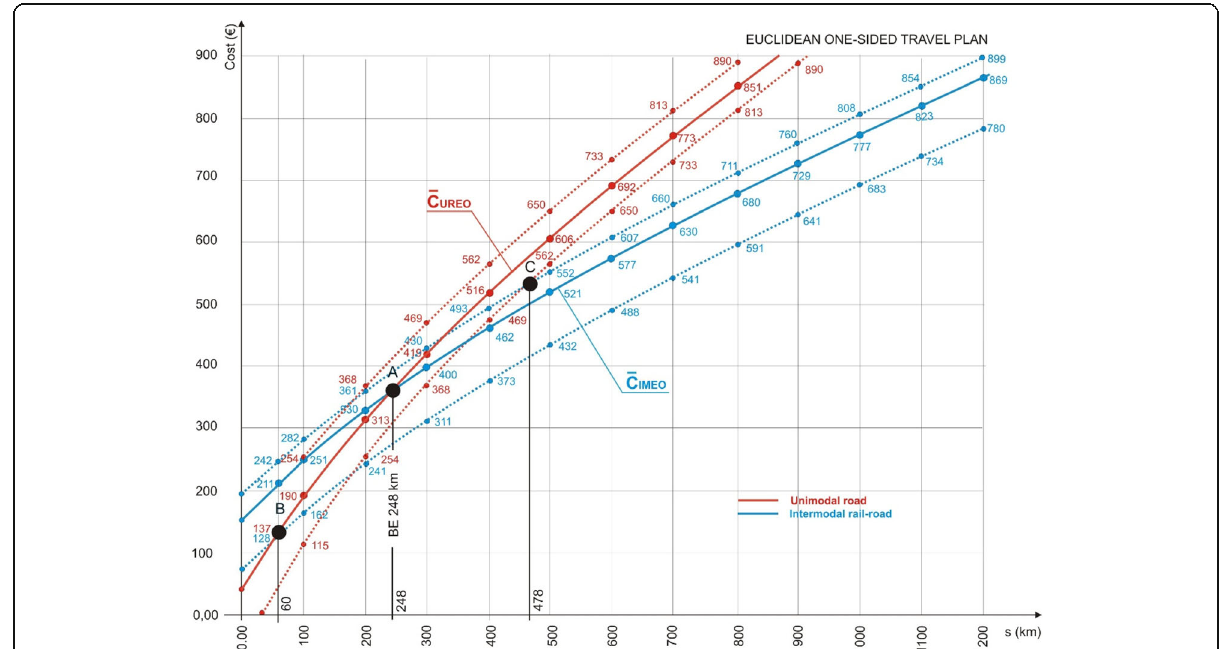
Fig. 9 Cost functions and break-even distances (Euclidean